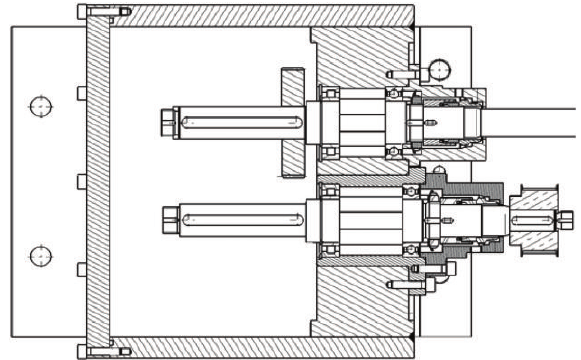
Figure 1: Geometry of the gearbox with the gear.